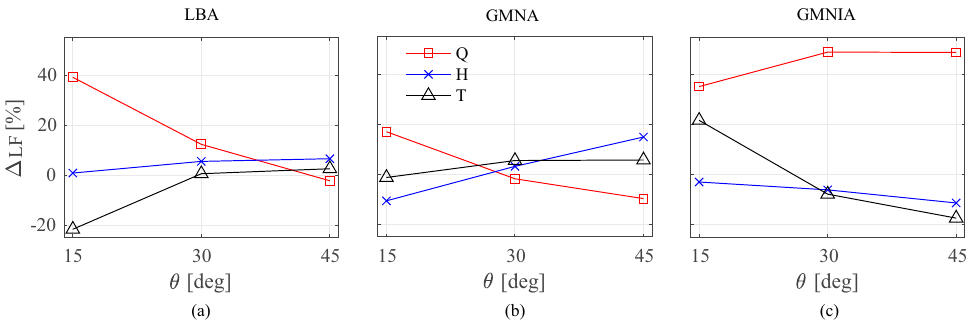
Figure 6: Percentage variation of the Load Factors ∆ LF obtained from (a) LBA, (b) GMNA and (c) GMNIA for each gridshell layout